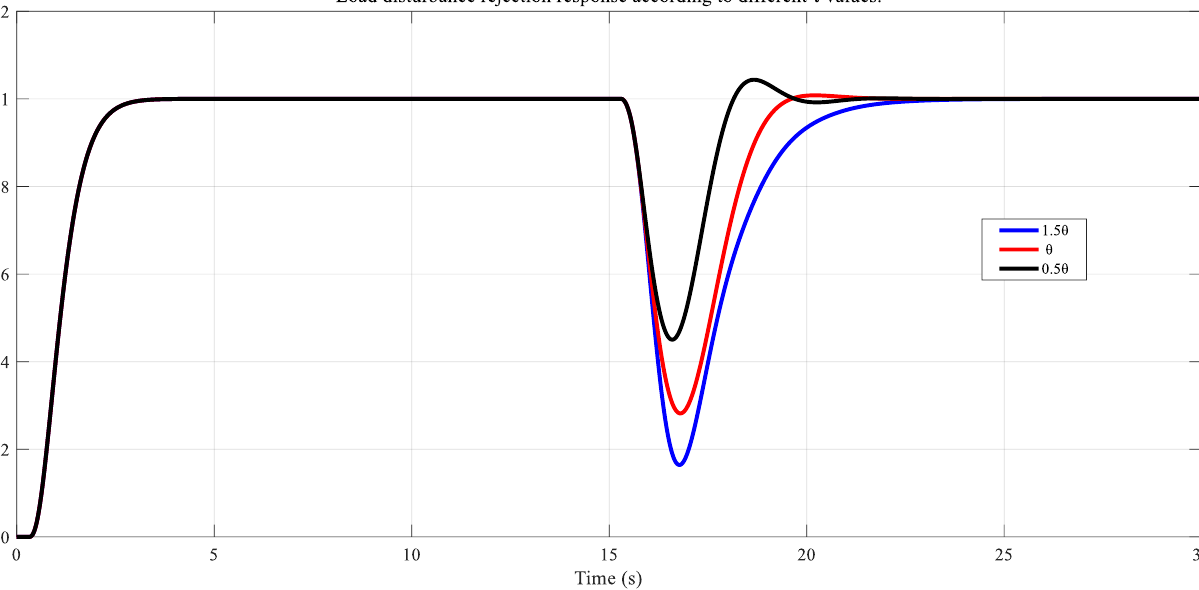
Figure 3. Load disturbance rejection response according to different ψ values. The process for the determination of τ and ψ , presented here, has been applied in other examples, which are not shown here. By substituting plant values of K = 2, θ = 0.3, T 1 = 3, and T 2 = 1 in Table 1, the controller parameters shown in Table 2 were obtained.